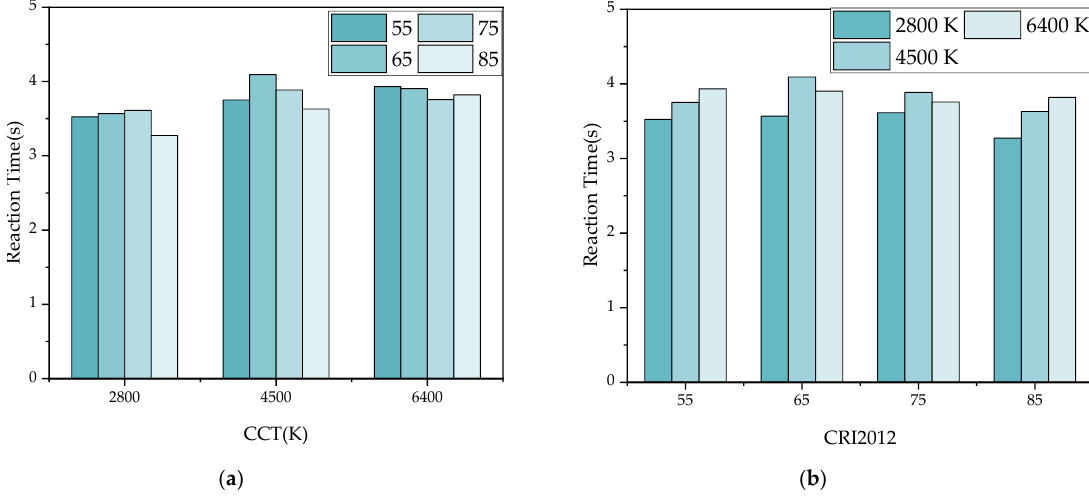
Figure 18. The average reaction time under 12 lighting conditions when HP-CCT is 3000 K. ( a ) Take the CCT as the horizontal axis. ( b ) Take the CRI2012 as the horizontal axis.